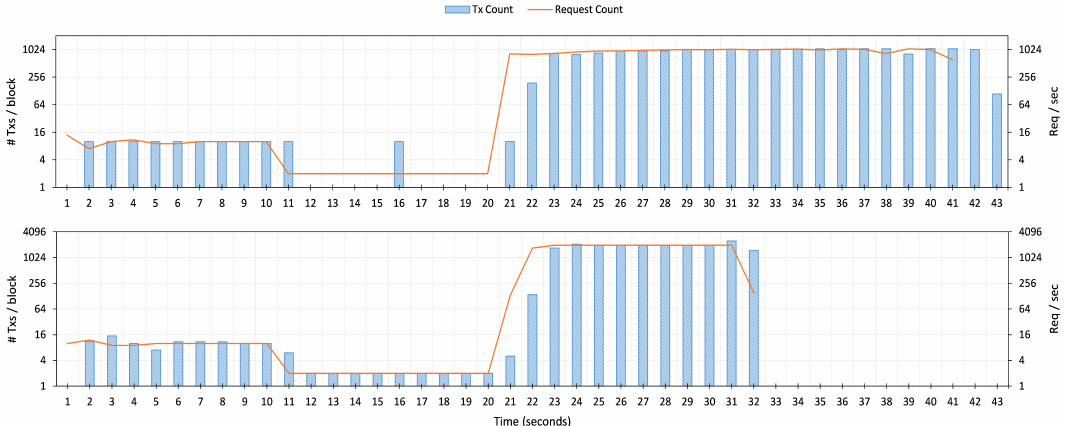
Figure 10. The comparison of the number of requests that the Notary node receives (Request Count), as well as, the number of requests included in the block (Tx Count) when using static Request Pool size of 10 ( top ) and dynamic Request Pool size ( bottom